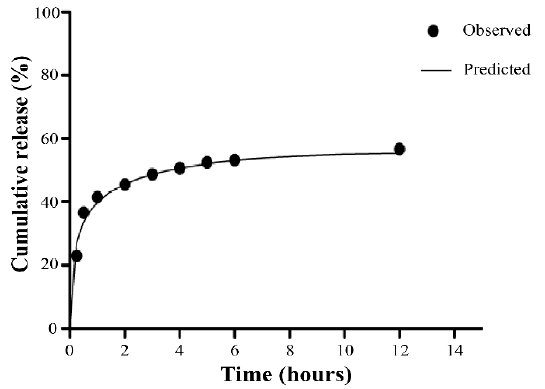
Figure 8. Cumulative drug release profile of the microparticles prepared by the water-in-water emulsion method (Formulation XBM-Ca-F9. Average ± SD. n = 3).